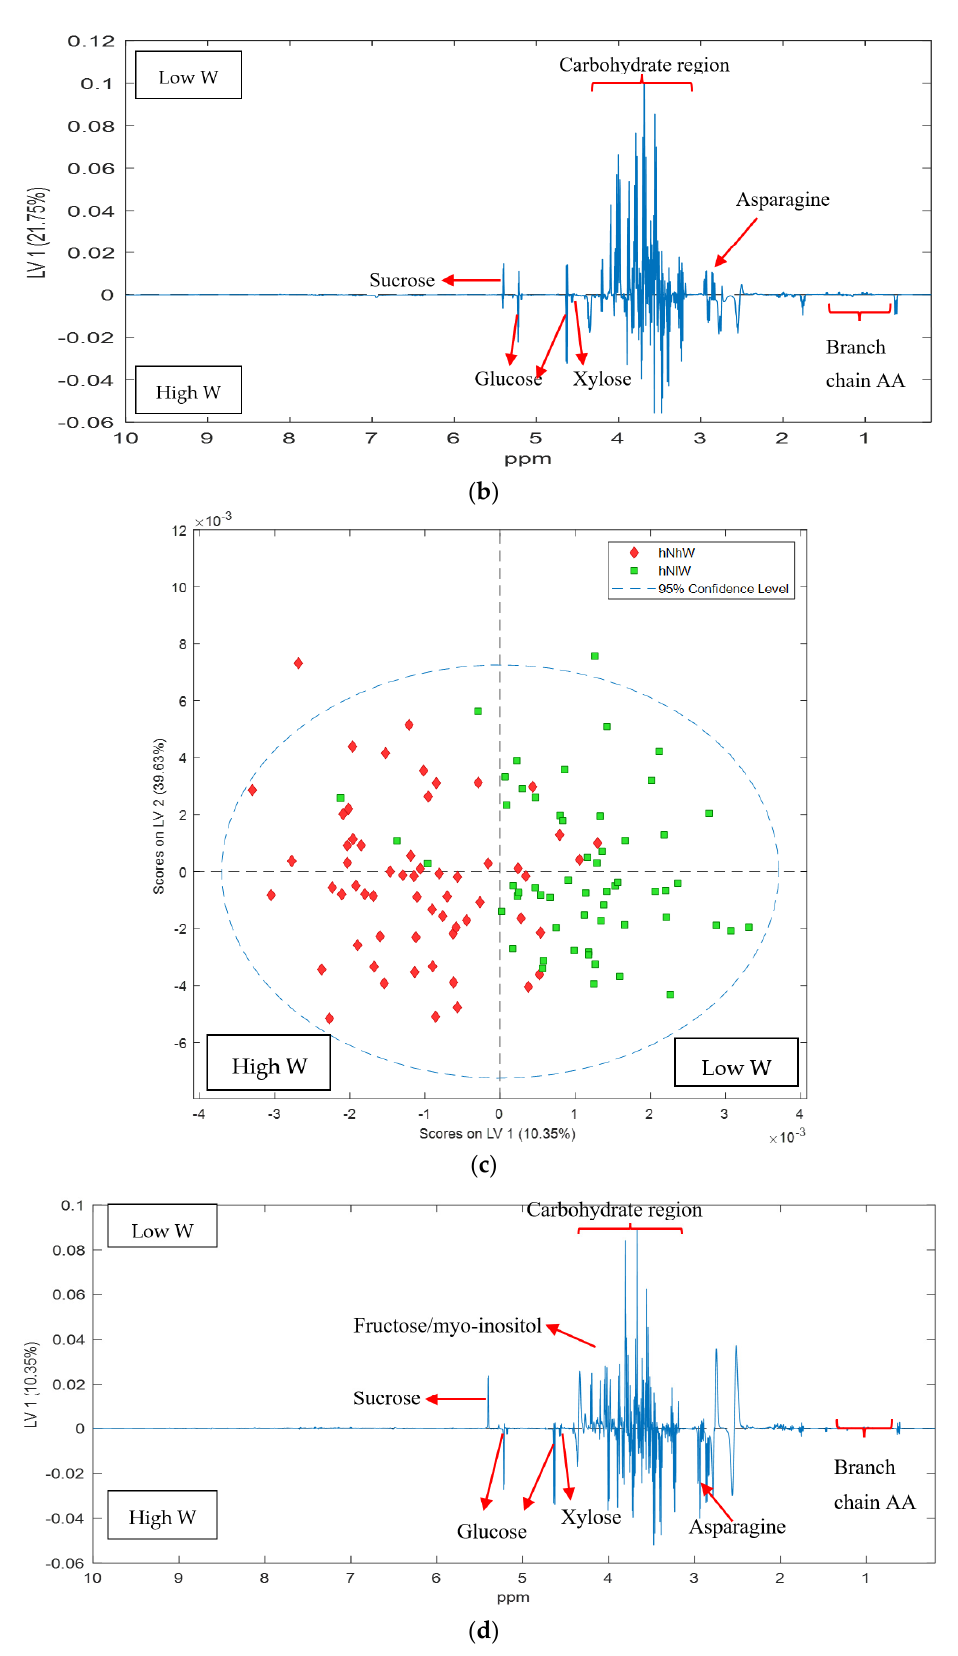
Figure 4. PLS-DA scores plot of 1 H NMR data of Nonpareil hull samples: ( a ) PLSDA score plot showing effect of water treatments on hull composition of samples from low N treatment with classification error on cross validation of 4% and